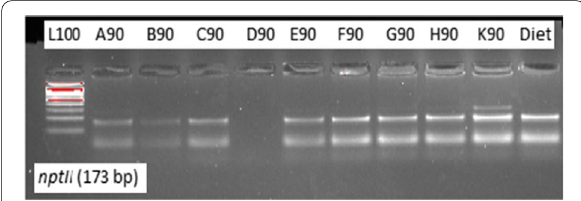
Fig. 3 PCR amplification products of nptII (173 bp) in blood samples of rats fed on GM‑diet for 90